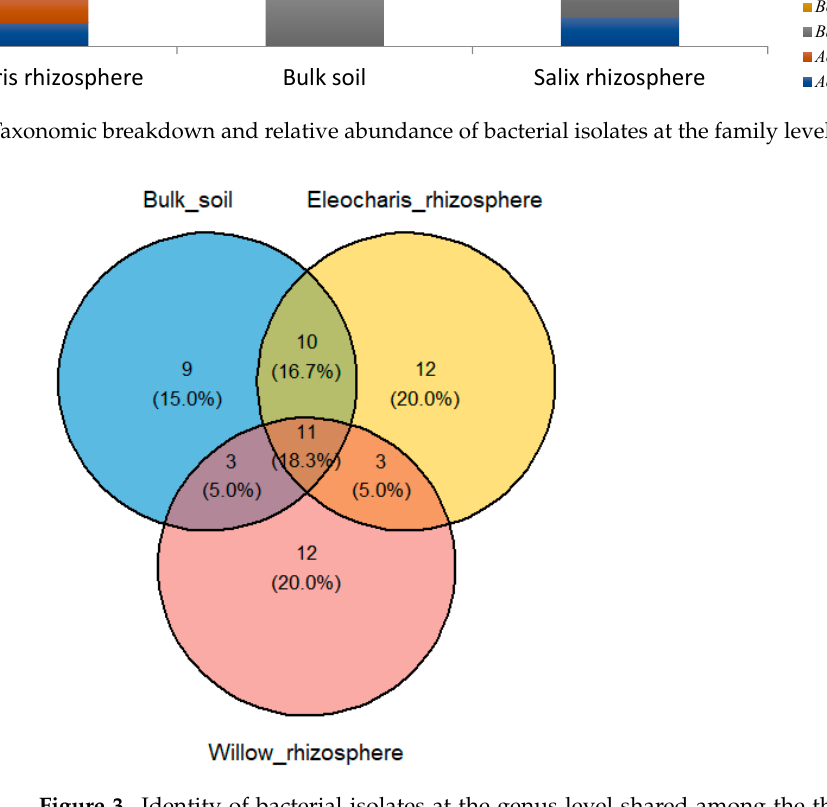
Figure 3. Identity of bacterial isolates at the genus level shared among the three environmental niches.